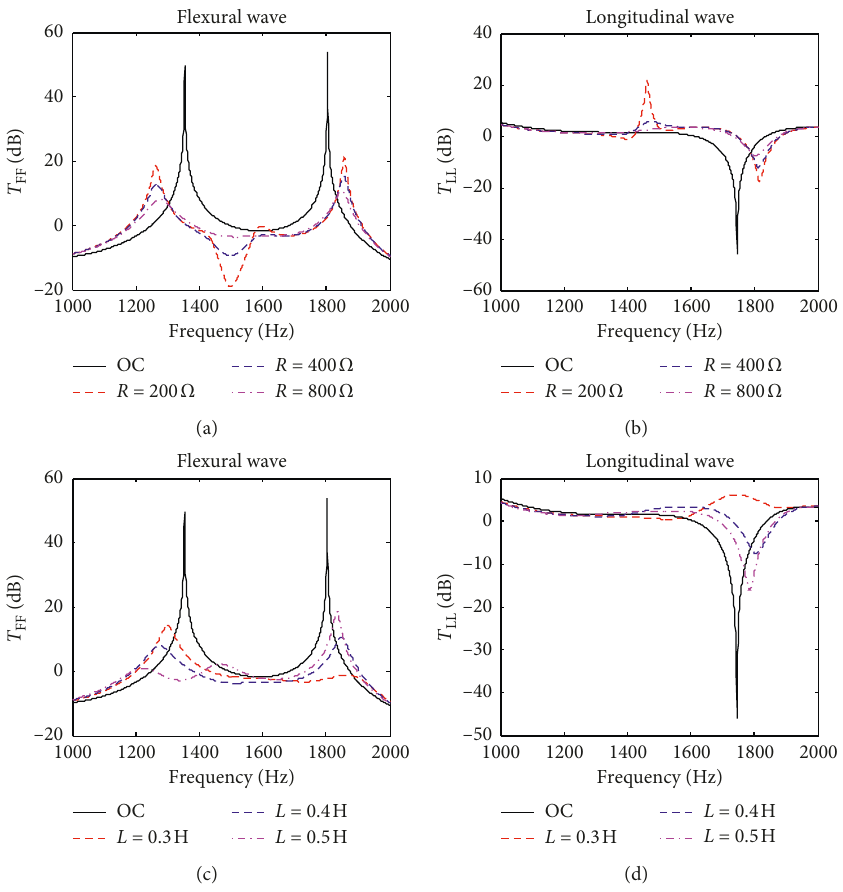
Figure 11: Variation of vibration transmissibility with circuit parameters. L � 0.4H in (a, b). R � 800 Ω in (c,